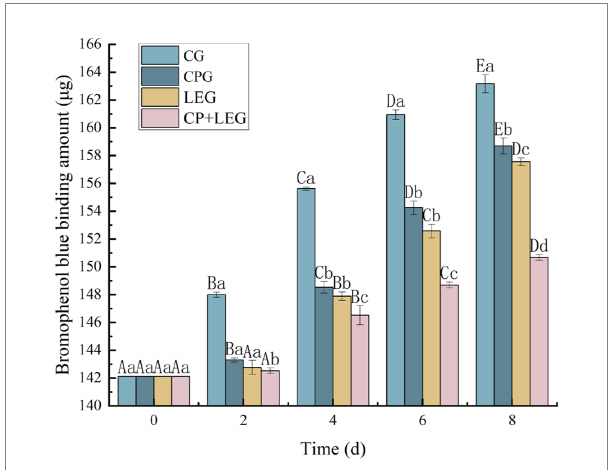
FIGURE 3 The absorbance value of thallus in OD600 under different conditions. CG, the control group; CPG, the compound preservative group; LEG, the low voltage variable frequency electric field group; CP+LEG, the compound preservative combined with low voltage variable frequency electric field group. Data were obtained as the mean ± standard deviation ( n =